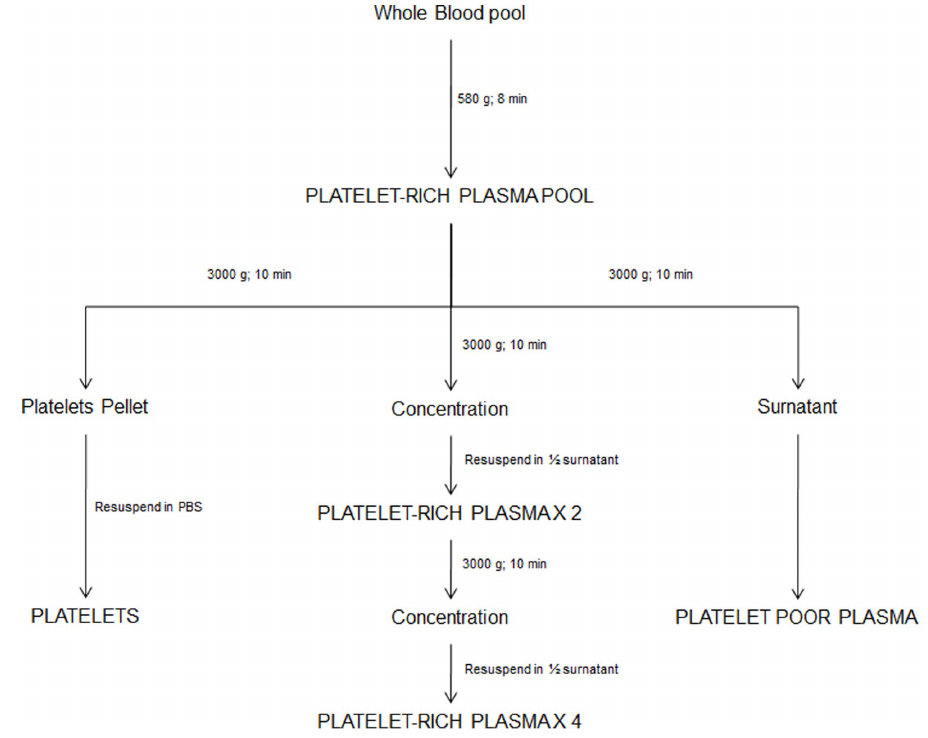
Figure 1. Experimental design of the study. The image illustrates the procedure used to obtain P-PRP, PPP, the pure platelet solution, 2-fold and 4-fold concentrated P-PRP. Starting from a whole blood pool, a P-PRP pool was obtained by centrifugation at 580 g for 8 minutes. Subsequently, P- PRP pool was divided into three equal aliquots and processed in order to obtain the different materials under evaluation in this study.